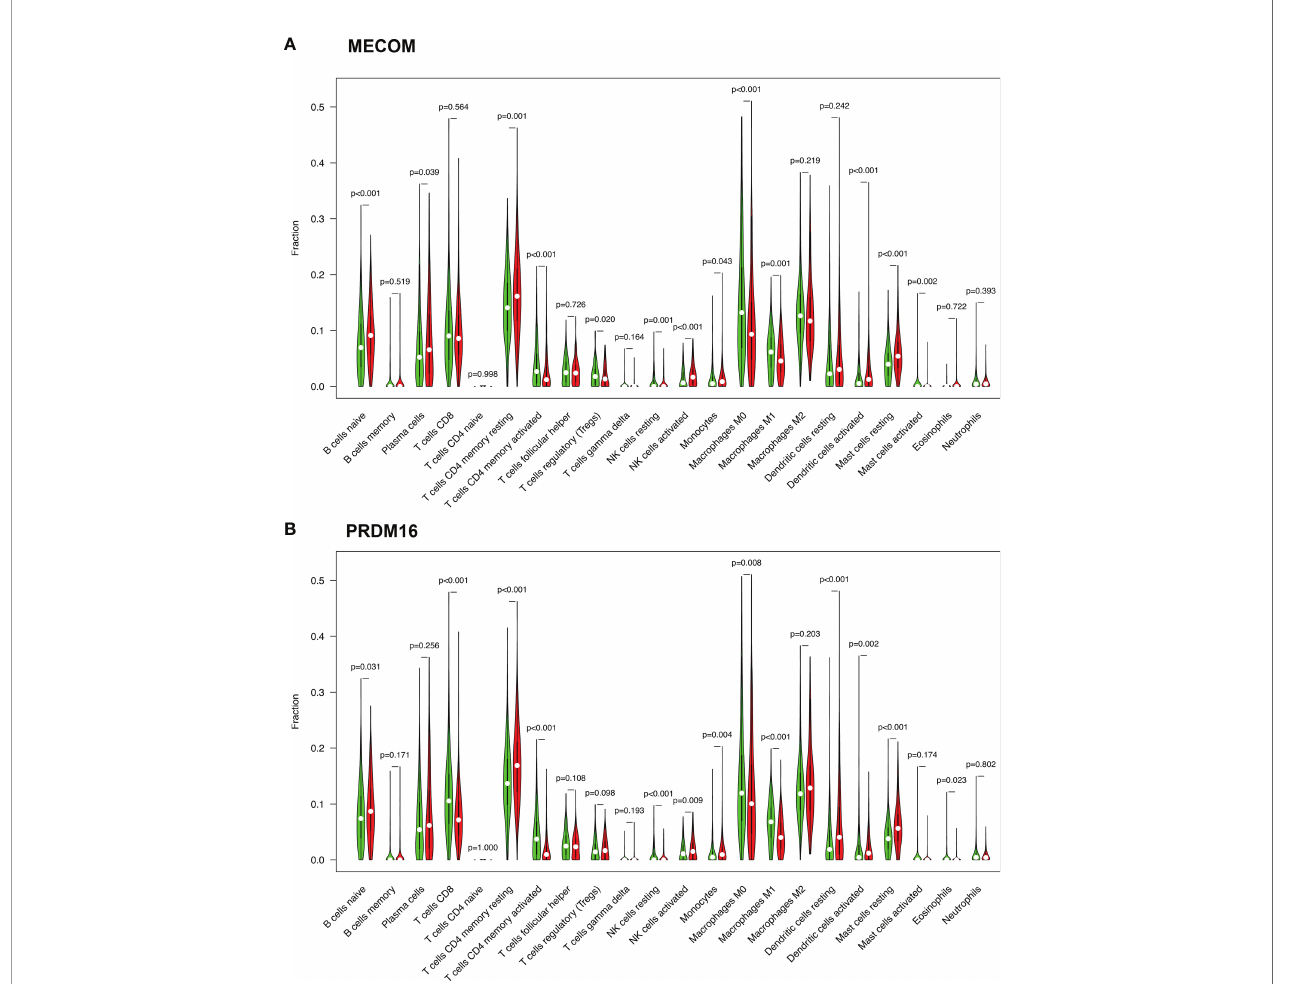
FIGURE 5 | Expression of immune cells in LUAD patients with high and low expression of MECOM (A) and PRDM16 (B) . MECOM, MDS1 and EVI1 complex locus, also called PRDM3; PRDM16, PR domain containing 16, also called MEL1; LUAD, lung